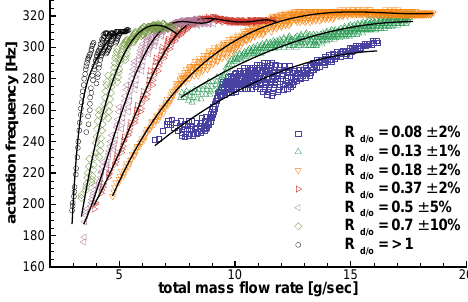
Figure 4. Frequency map for Segment